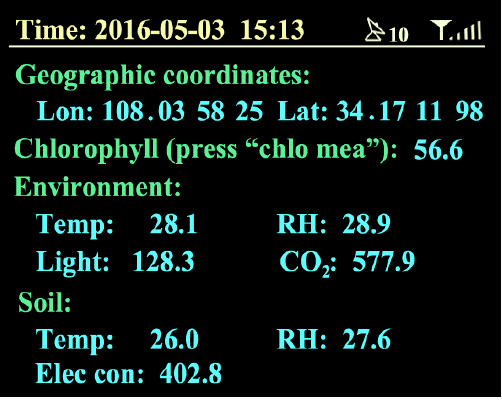
Figure 9. Sample of farmland information—on 3 May 2016, at 15:13—including with the geographic coordinates by Lon (longitude, degree) and Lat (latitude, degree), Chlorophyll (chlorophyll relative content, SPAD), Environment information by the Temp (air temperature, °C), RH (air humidity, %), Light (light intensity, Lx), and CO 2 (CO 2 concentration, ppm) and Soil information by the Temp (soil temperature, °C), RH (soil humidity, %), and Elec con (soil electrical conductivity, μ s/cm).